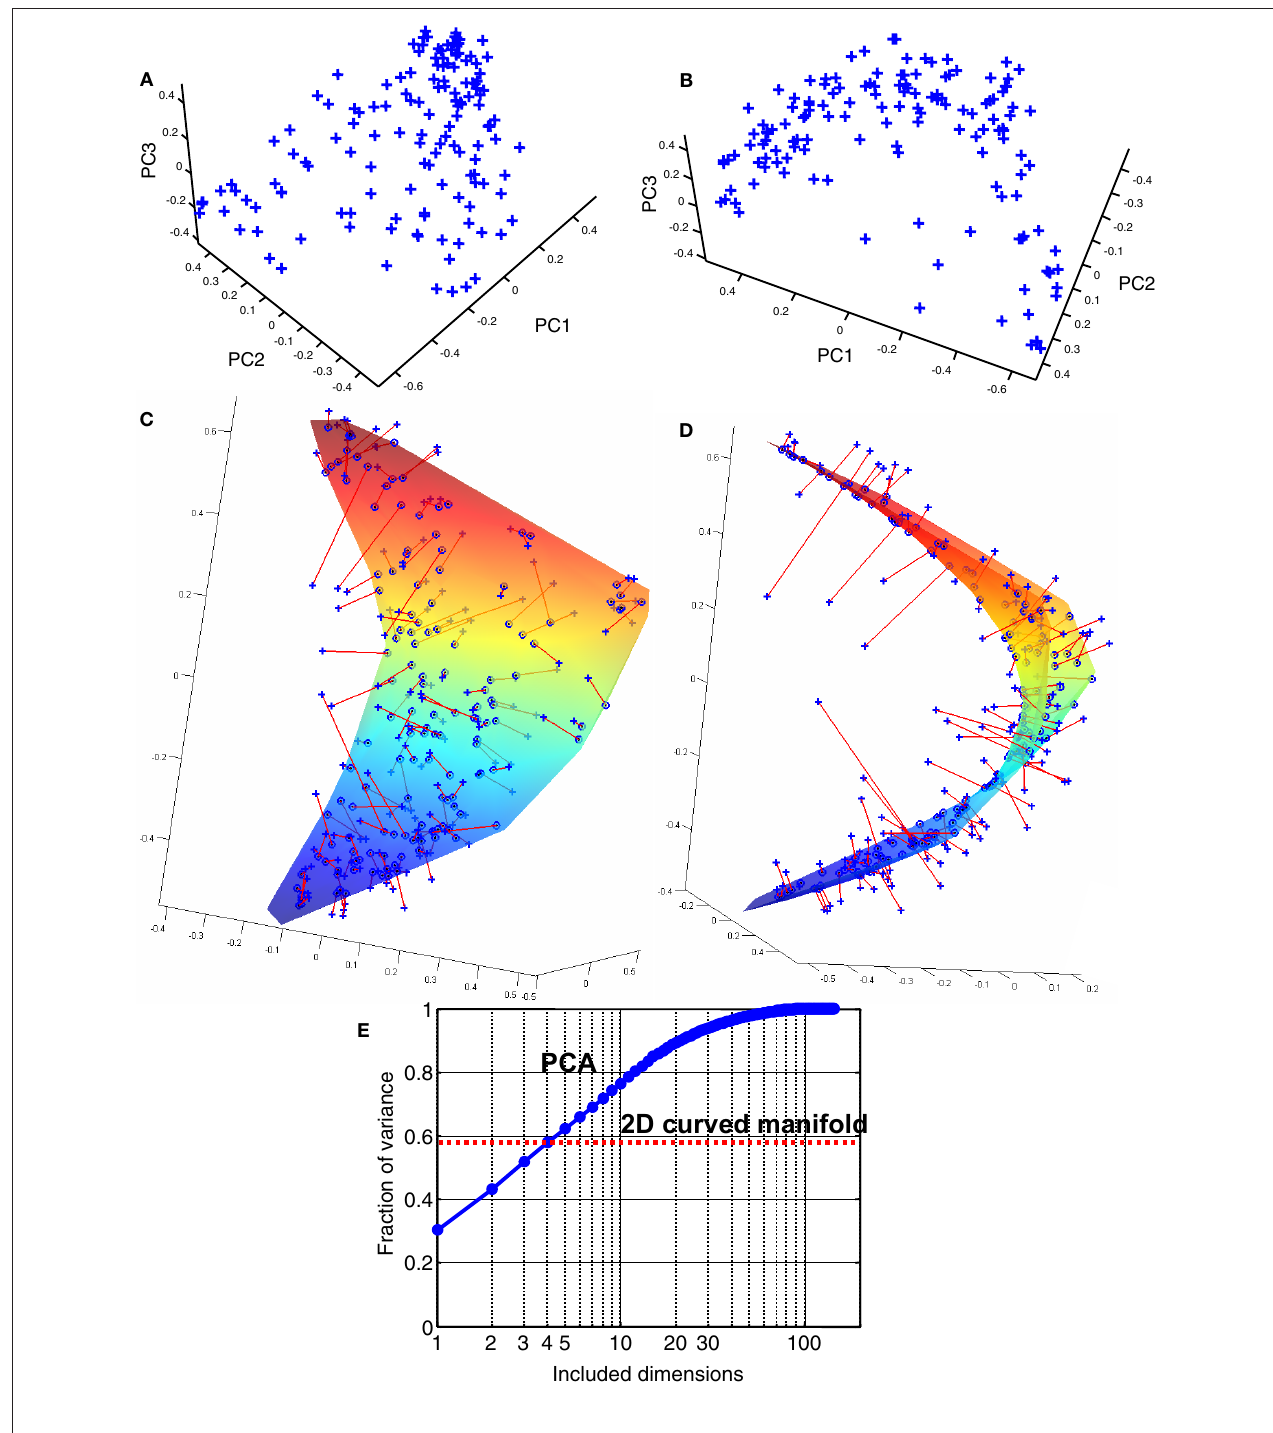
surface by the red lines representing the residual errors. The 2D surface minimizes the total squared length of the residuals computed in 146D. The total squared length of residuals can be viewed as the remaining variance in the data not accounted for by the projection onto the 2D curved manifold. (e) The fraction of included variance as a function of the number of PCA dimensions. The fraction of variance accounted by the 2D curved manifold in (C) and (D) is 56% (red